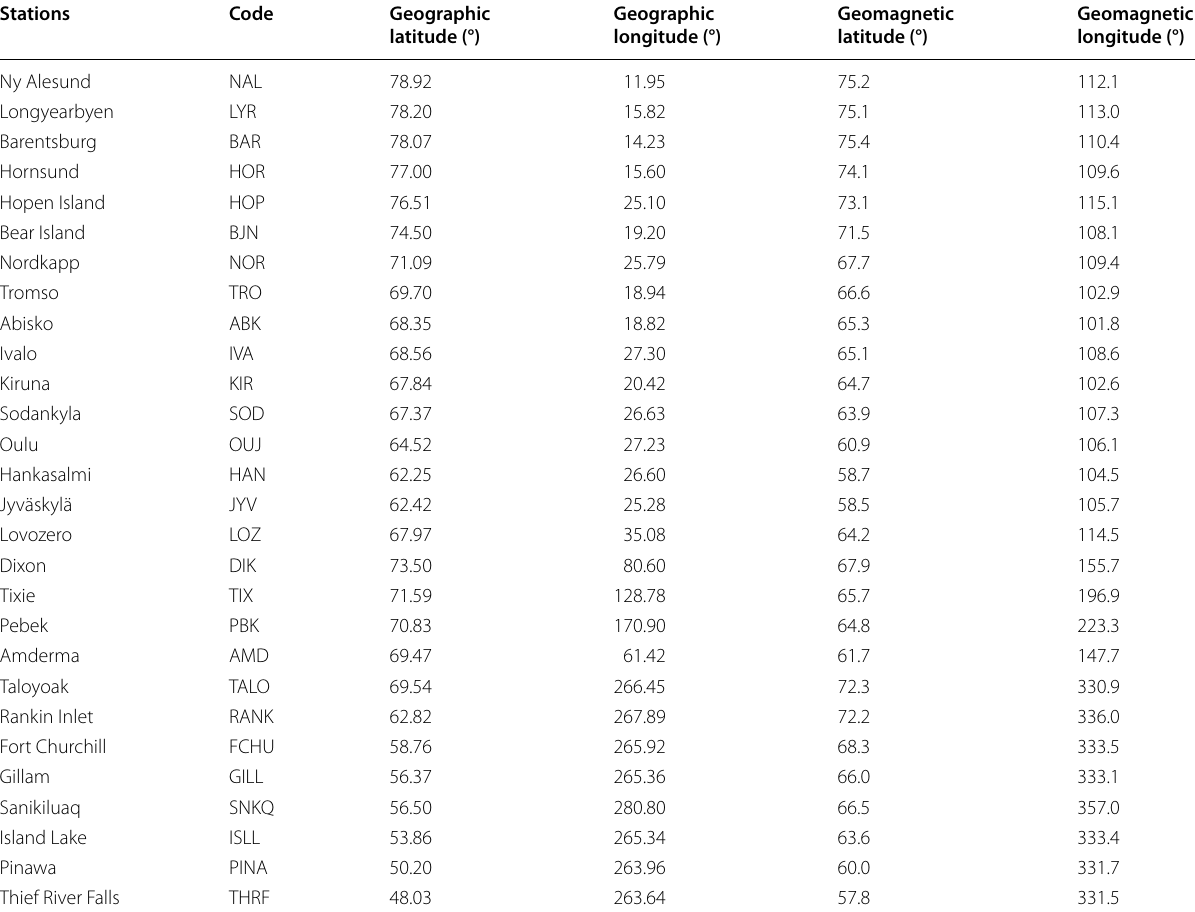
Table 1 Magnetometers, riometers, and GPS receivers Stations